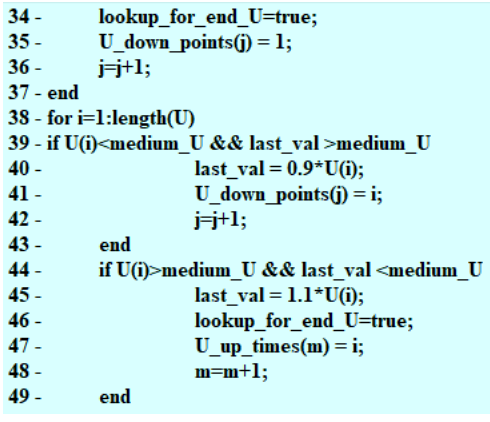
Figure 4. Selection of the search range.